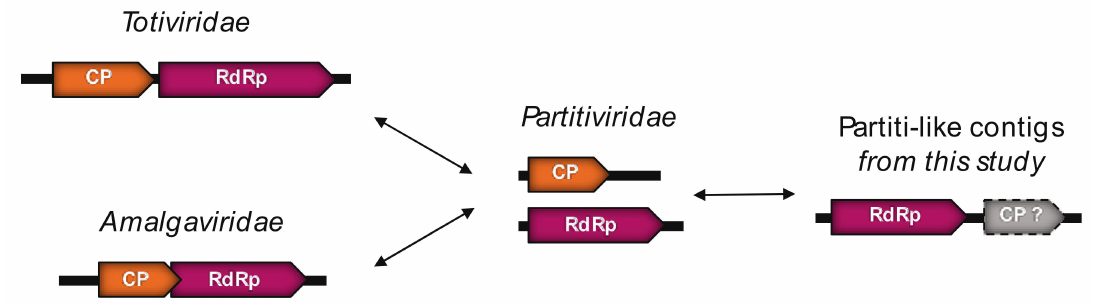
Figure 5. Genomic organization of the Partitiviridae , Totiviridae and Amalgaviridae . Possible evolutionary scenarios for the BDRC-like contigs observed in Ostreobium